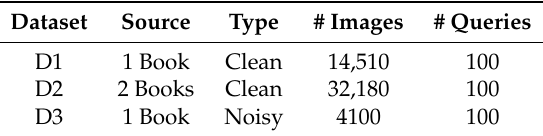
Table 2. Details of the datasets considered in the experiments. The first collection (D1) of words is from a book which is reasonably clean. The second dataset (D2) is obtained from 2 books and is used to demonstrate the performance in case of heterogeneous print styles. The third dataset (D3) is a noisy book. Dataset Source Type #